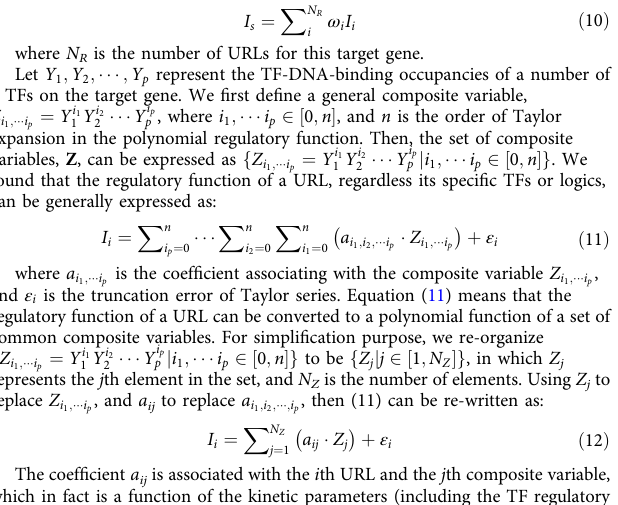
algorithm or method in identifying TF target genes. LogicTRN and four methods COGRIM 8 , APG 55 , NCA 4 , and PTHGRN 13 , were separately applied to analyze